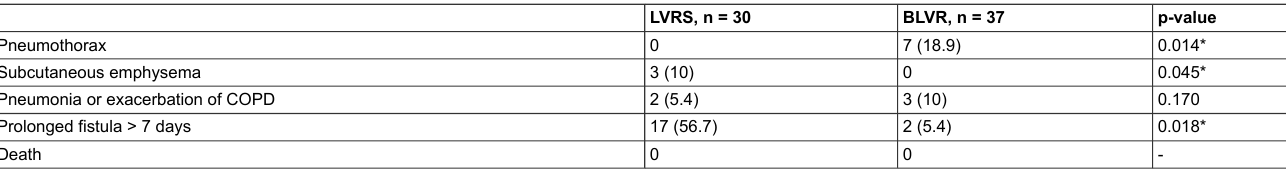
Table S3: In-hospital # events after lung volume reduction divided by method.